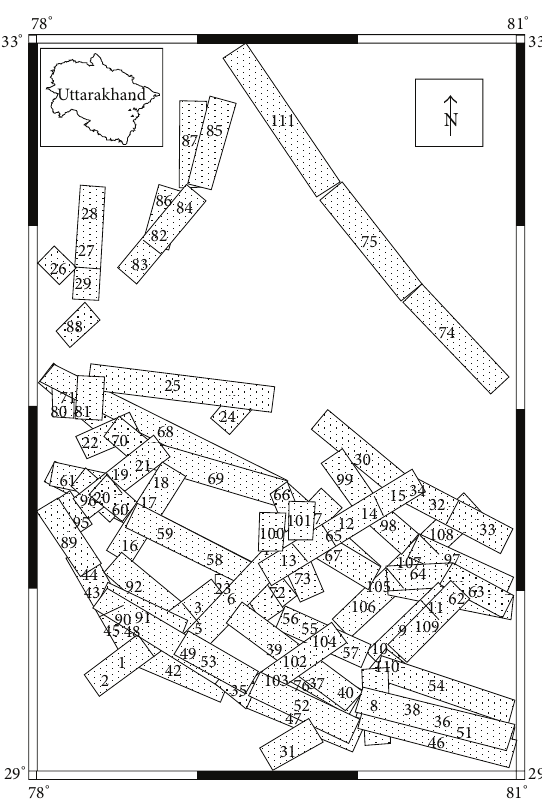
Figure 9: Modified tectonic map after GSI [22]. The shaded rectangle shows the rupture dimension and its name used for modeling for seismic hazard map.